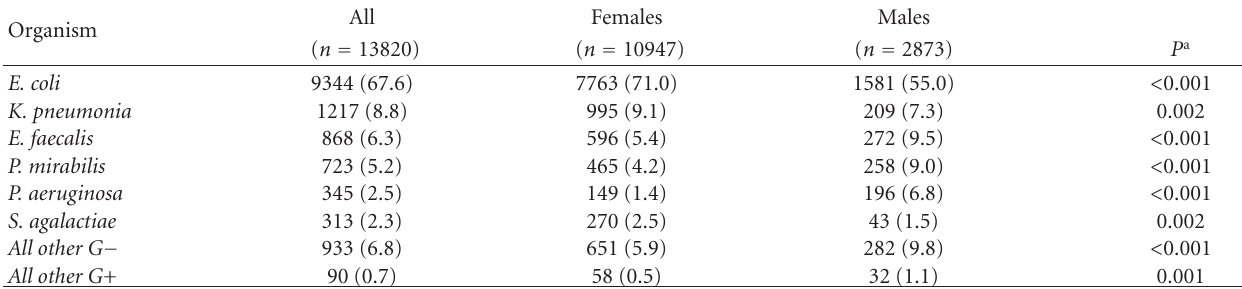
Table 2: Distribution of the six more frequently isolated species according to patients’ gender.